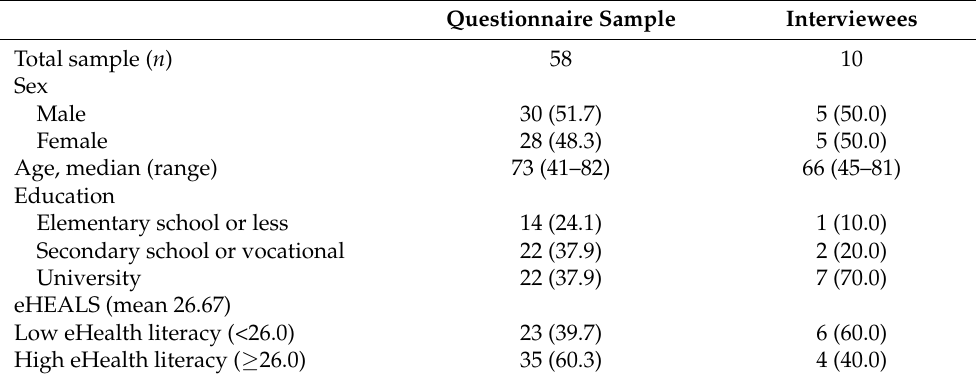
Table 1. Demographic characteristics of participants in respective data collection